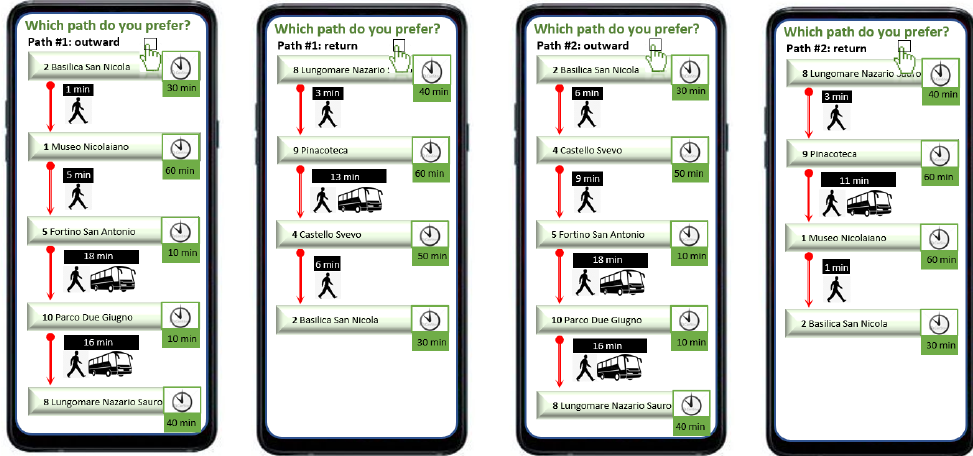
Figure 18. The GUI of the feasible solutions.